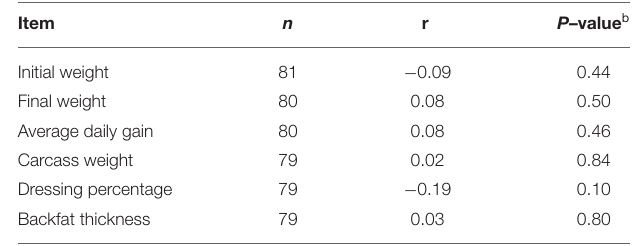
TABLE 4 | Coefficient (r) of Spearman rank correlation of Ascaris suum fecal egg count with growth performance and carcass traits of infected finishing pigs a at 23 weeks of